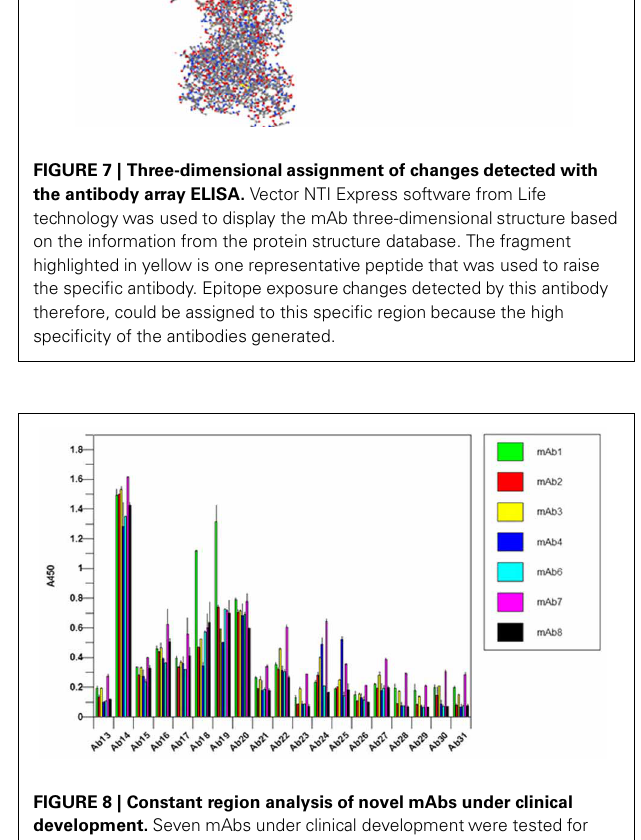
FIGURE 8 | Constant region analysis of novel mAbs under clinical development. Seven mAbs under clinical development were tested for their surface epitope exposure, the common set of antibodies raised against Herceptin constant region was used for the